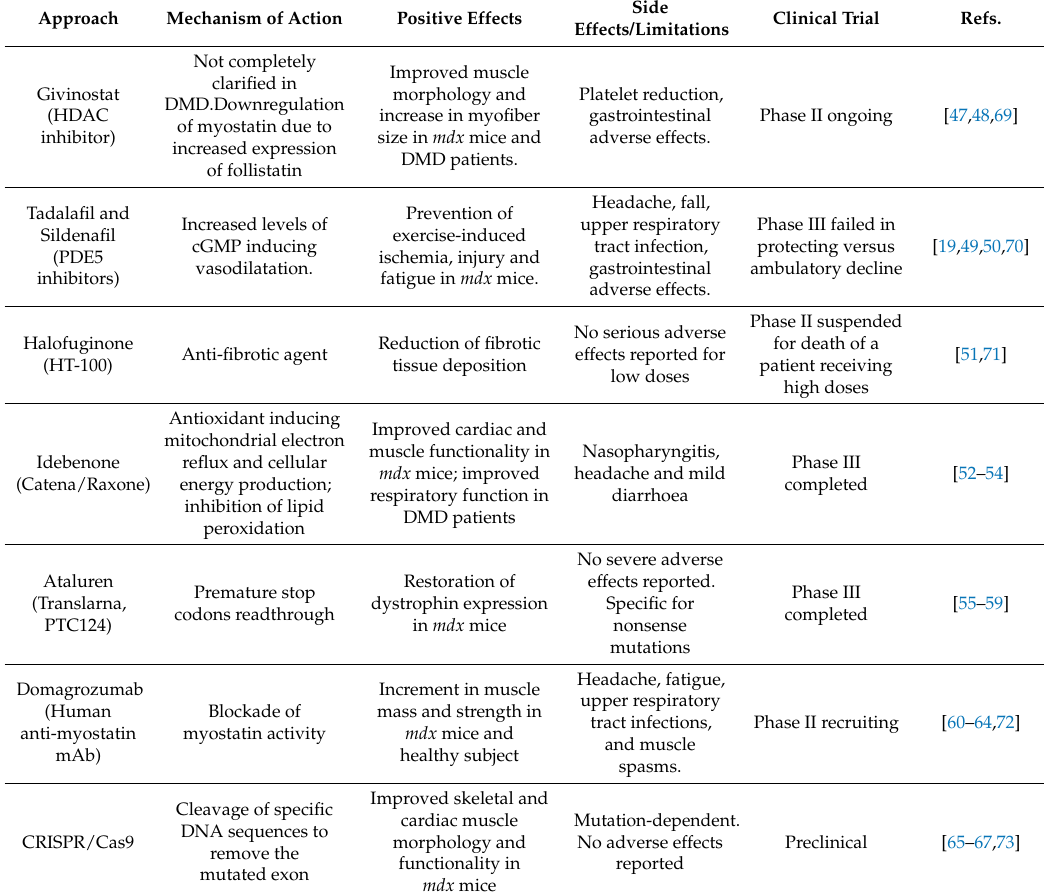
Table 1. Mechanisms of action and effects of alternative approaches of Section